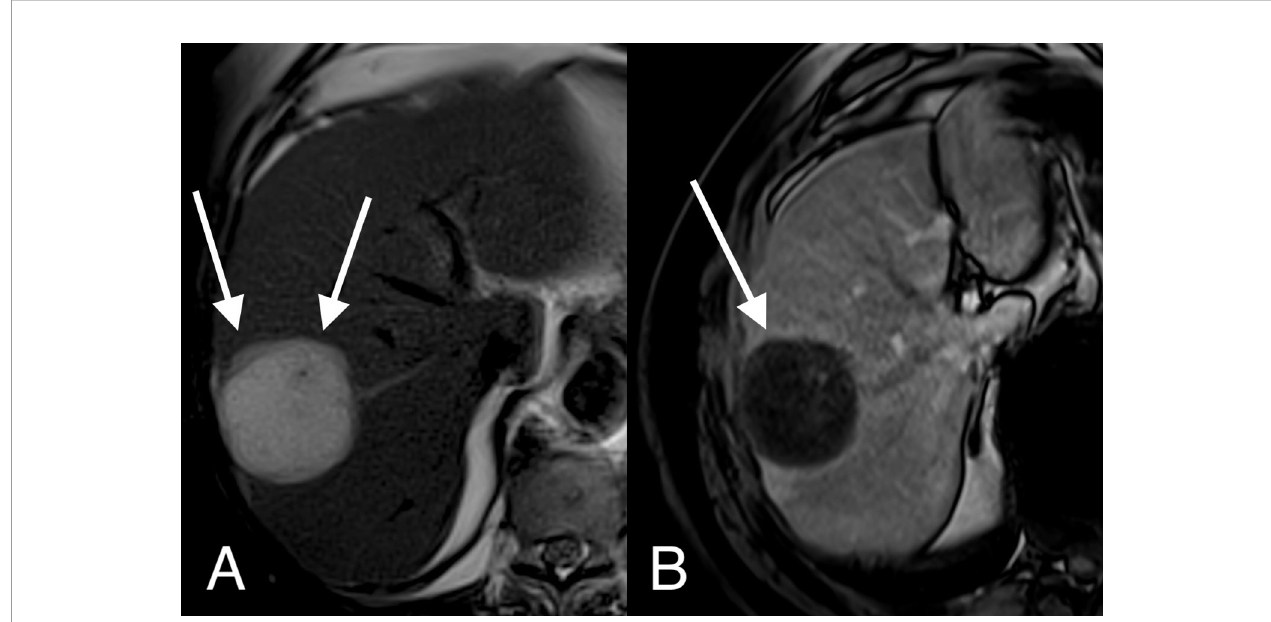
FIGURE 4 | MRI image of a mucinous colorectal liver metastasis.Axial T2 weighted (A) and T1 weighted gadolinium enhanced (B) MRI images demonstrate a large T2 bright, cystic appearing lesion in segments 7 and 8 with a thick wall (arrows) and a thin rim of post-contrast enhancement.